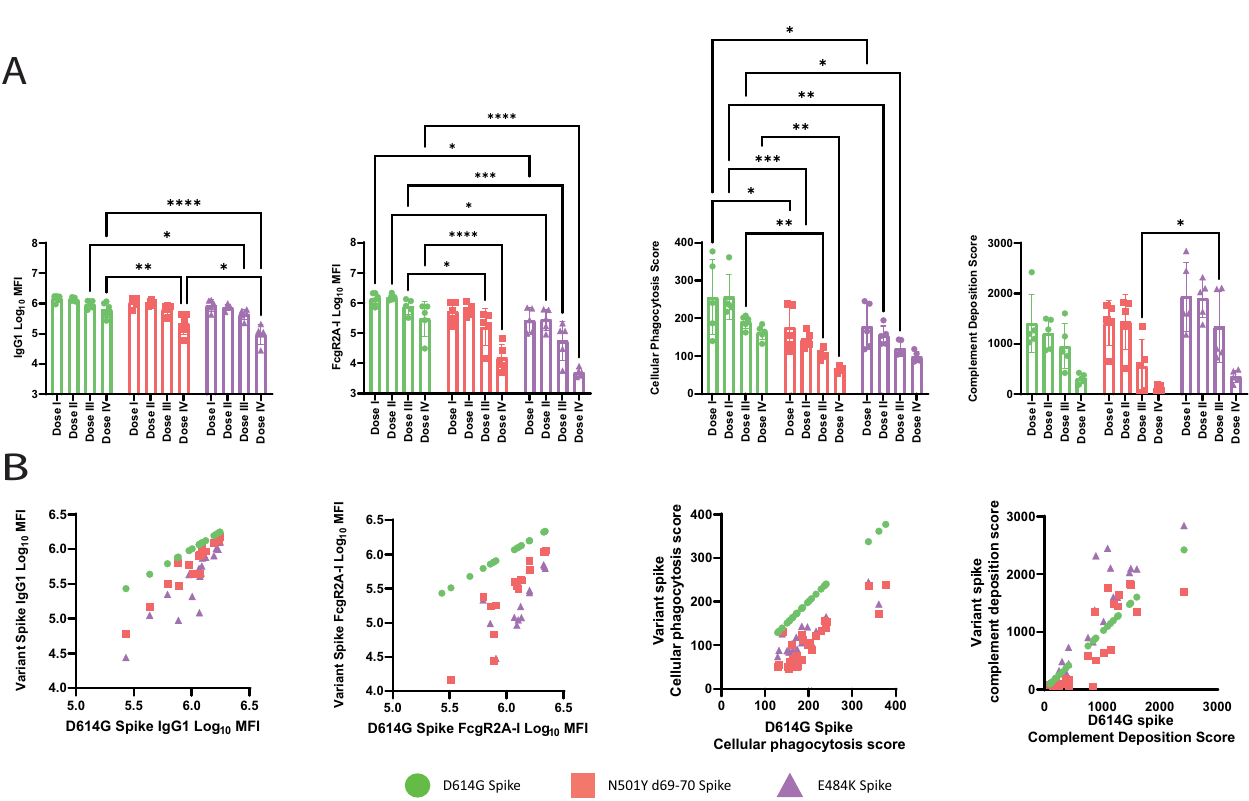
Fig 7. Humoral response to VOCs. (A) The humoral response of vaccinated NHPs was profiled against several SARS-CoV-2 spike proteins (Spike: D614G, N501Y Δ 69–70, and E484K). The antibody titers and FcR binding titers were assayed by Luminex and the functional responses were analyzed using their respective assays. The bars represent the median response and error bars represent standard deviation. (B) The dot plots show the correlation of the IgG1 titer, FcRgIIA-I binding titer, ADCP, or complement deposition between D614G SARS-CoV-2 and the variants N501Y Δ 69–70 and E484K. D614G is plotted as an example of perfect correlation. A 2-way ANOVA with Tukey correction for multiple comparisons was used to compare antibody levels between groups. Only significant comparisons are shown. ns, not significant, � p � 0.05, �� p � 0.01, ��� p � 0.001, ���� p � 0.0001. This figure can be generated from the data found in data/figure7_data.csv of https://github.com/dzhu8/Ad26-Dose-Down. ADCP, antibody-dependent cellular phagocytosis; FcR, Fc γ receptor; MFI, median fluorescent intensity; NHP, nonhuman primate; SARS-CoV-2, Severe Acute Respiratory Syndrome Coronavirus 2; VOC, variant of concern.